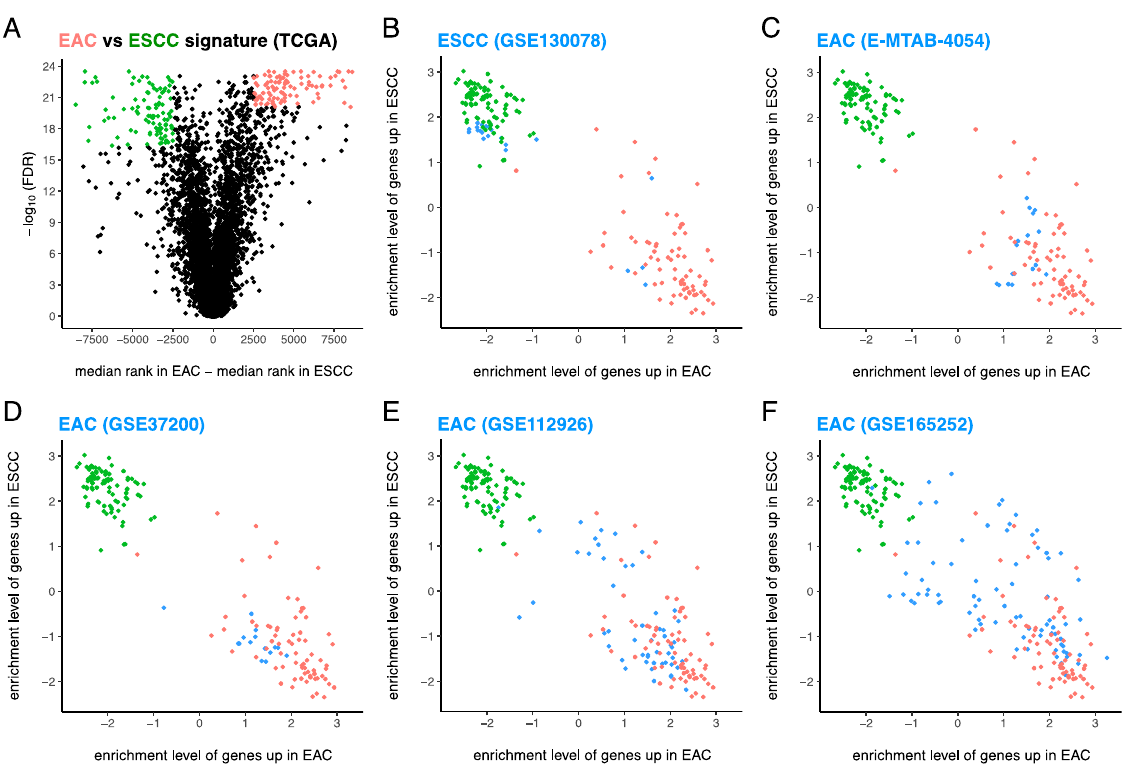
Figure 1. Construction and validation of gene expression signatures of esophageal adenocarcinoma (EAC) and esophageal squamous cell carcinoma (ESCC). ( A ) Gene expression signatures of EAC (consisting of 100 EAC hi genes in red) and ESCC (consisting of 100 ESCC hi genes in green) constructed from the Cancer Genome Atlas. Validation of these gene expression signatures in ( B ) a dataset of ESCC and ( C – F ) 4 datasets of EAC. Red = EAC cases from TCGA, green = ESCC cases from TCGA, and blue = test samples (various types of samples from datasets other than TCGA).